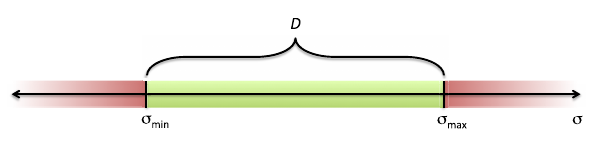
FIGURE 1 | Illustration of valid set D . The set-based task (cid:27) is satisfied in D and violated outside of D